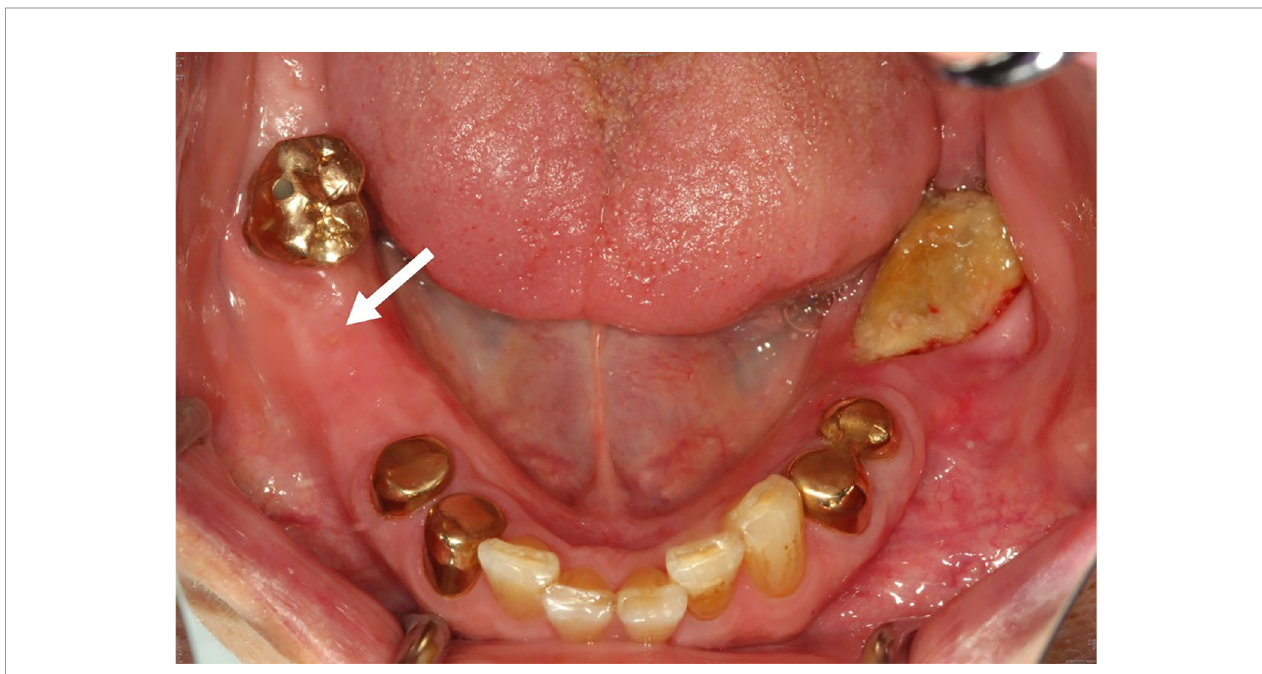
FIGURE 1 | Clinical presentation of the MRONJ showing bone exposure in regions 36 to 38 and a fi stula and palpable bone in region 46 (white